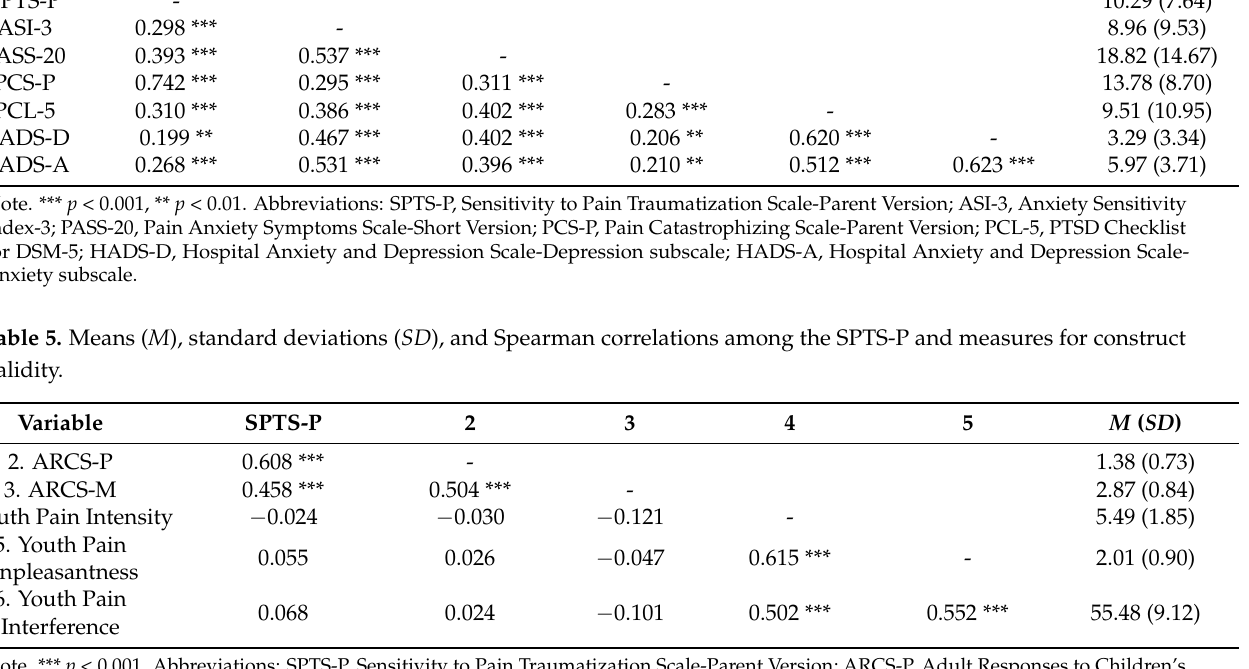
Table 4. Means ( M ), standard deviations ( SD ), and Spearman correlations among the SPTS-P and related constructs. Variable